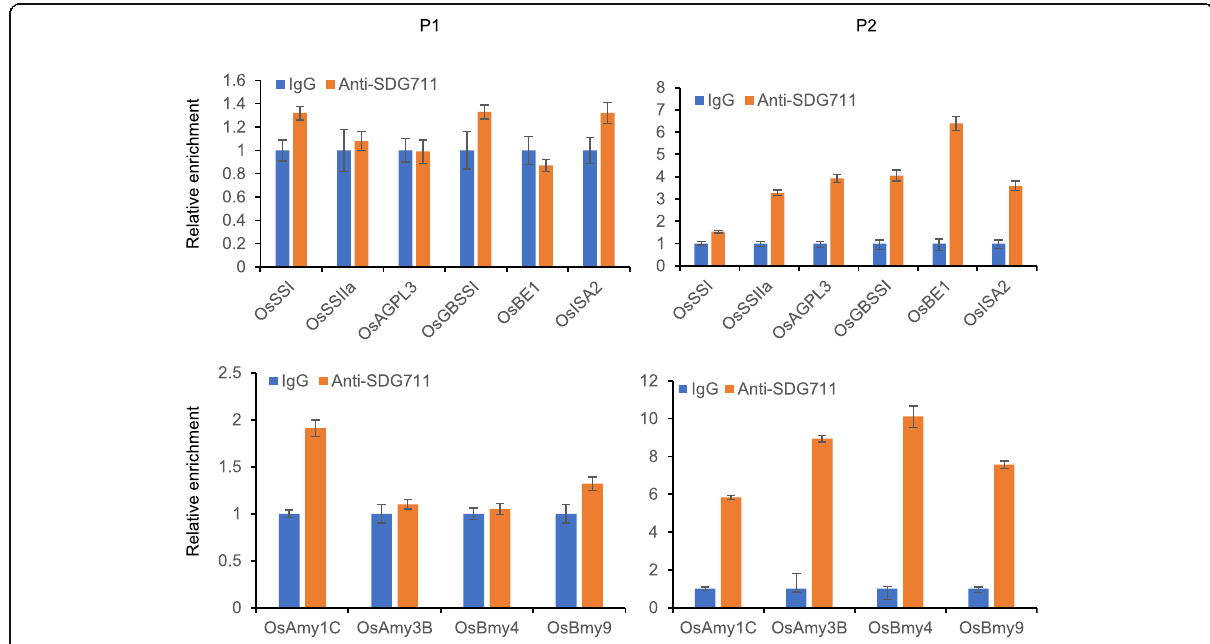
Fig. 5 Direct association of SDG711 protein with genes of starch metabolism. SDG711 protein enrichment of the starch metabolism genes in WT seeds at 3 DAP tested by ChIP with anti-SDG711. Non-immunized serum (IgG) was used as a control. SDG711 protein enrichment at the 5 ′ transcriptional start site (TSS) (P1) and 5 ′ end of the gene body (P2) was detected by quantitative PCR (q-PCR). Each q-PCR assay was repeated three times. Values are the mean ± SD from three technical